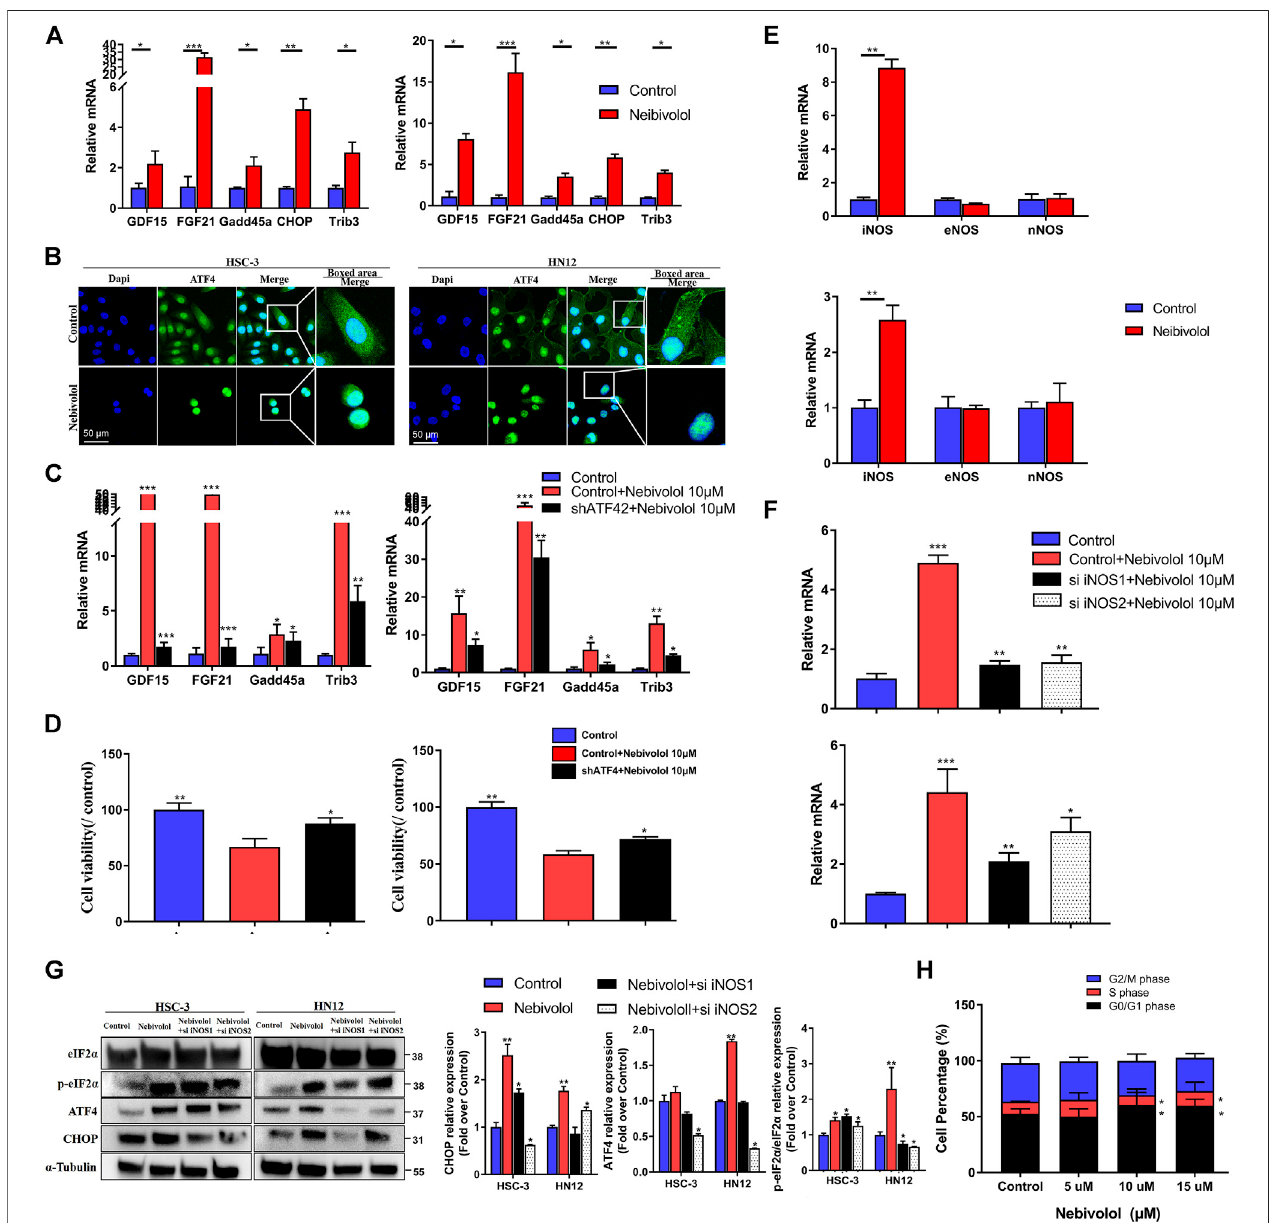
FIGURE5| Nitricoxidesynthase(iNOS)accumulationcontributedtonebivolol-inducedERstressinOSCCcells. (A) TheqRT-PCRanalysiscon fi rmedthattheISR gene was upregulated after being treated with nebivolol in OSCC cells. (B) Immuno fl uorescent images showing the translocation of ATF4 in OSCC cells after induction withnebivolol.The OSCC cells were stained with markers ofthe nucleus (DAPI, blue). Theimagesare based on three independentexperiments observed byCLSM. (C) The qRT-PCR analysiscon fi rmed thatthe ISR genewas downregulatedin the shATF4-transfected cells after being treated with nebivolol for 12 h when compared to the nebivolol-stimulated OSCC cells. (D) The cell viability were increased in the shATF4-transfected cells groups after being treated with nebivolol for 12 h when compared to the alone nebivolol-treated groups. (E) qRT-PCR analysis showed that iNOS gene expression was enhanced after being treated with nebivolol in OSCC cells. (F) The qRT-PCR analysis con fi rmed that iNOS gene expression was decreased in the nebivolol-induced si iNOS groups when compared to the nebivolol- stimulated OSCC cells. (G) Western blotting of total and phosphorylated eIF2 α , ATF4, and CHOP in OSCC cells in the nebivolol-induced si iNOS groups and the nebivolol-inducedgroups.The p -eIF2 α ,ATF4,andCHOPfromtheblotswerequanti fi ed. (H) Cellsweretreatedwiththeindicatedconcentrationofnebivololfor12 hand the cellcycle distributions weredetected by fl owcytometry assay.Datarepresentthemean ± SD ofthree replicate independent experiments. Theasterisk (*)indicatesa signi fi cant difference compared to the control group (* p < 0.05, ** p < 0.01, and *** p < 0.001).